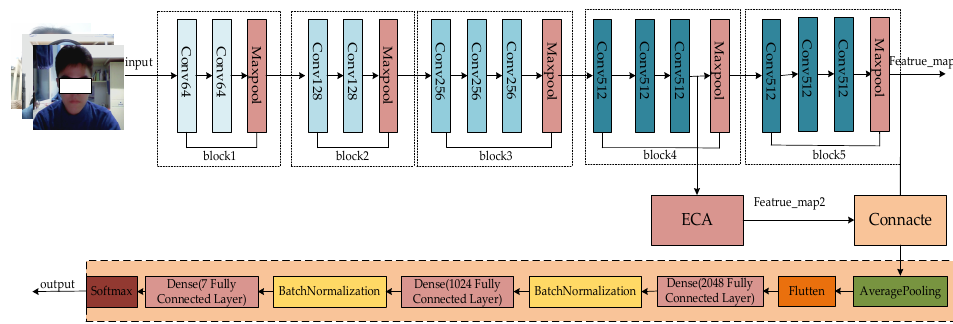
Figure 7. The overall structure of the model.